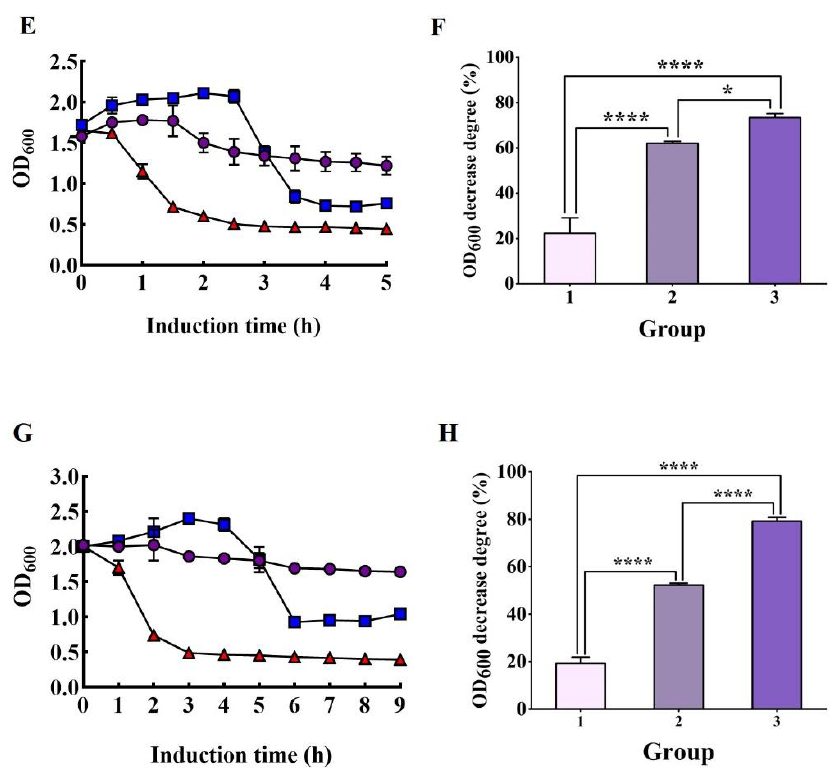
Figure 1. The lysis curves of E. coli BL21(DE3) harboring different lysis plasmids. The OD 600 value of bacteria cells was measured to assess the lysis activity of bacteria ( A , C , E , G ). At the same time, the significance analysis of OD 600 decrease degree of different lysis plasmids was conducted ( B , D , F , H ). The OD 600 values at different times were expressed as mean ± standard deviation (S.D). The initial induction OD 600 values were 0.8 ( A , B ), 1.2 ( C , D ), 1.6 ( E , F ), and 2.0 ( G , H ), respectively. Note: "ns" meant there was no significant difference. And “*”, “**”, “***” and “****” represented “ p < 0.05”, “ p < 0.01”, “ p < 0.001”, and “ p < 0.0001”, respectively, which had significant differences. Table 2. The lysis efficiency of E. coli BL21(DE3) harboring different lysis plasmids. Initial